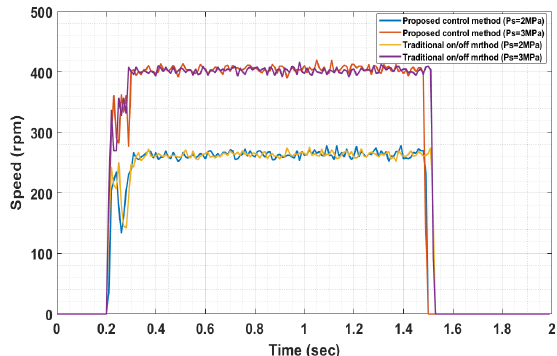
Figure 167. Hydraulic motor speed when the solenoid valve is excited by the proposed control and traditional methods under different supply pressures (2 MPa and 3